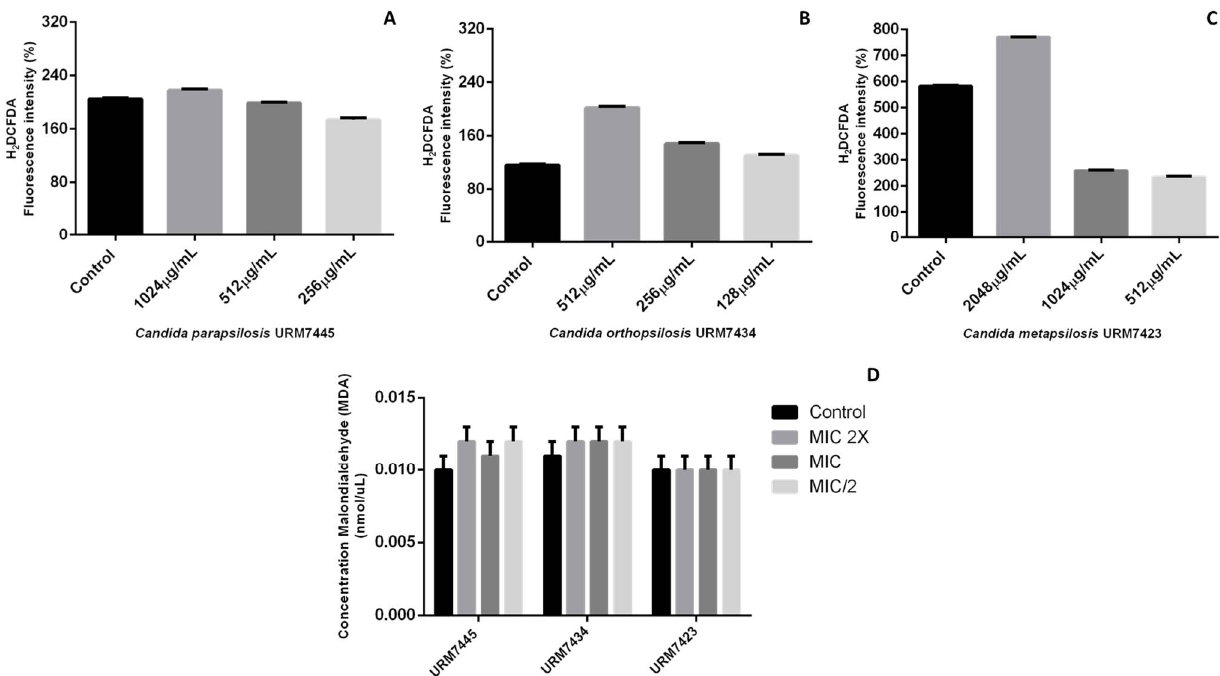
Figure 4. Detection of reactive oxygen species ( A – C ) and lipid peroxidation ( D ) for Candida parapsilosis complex species. For the analysis, a Tukey′s multiple comparison test was performed for all means obtained at a significance level of 5%.